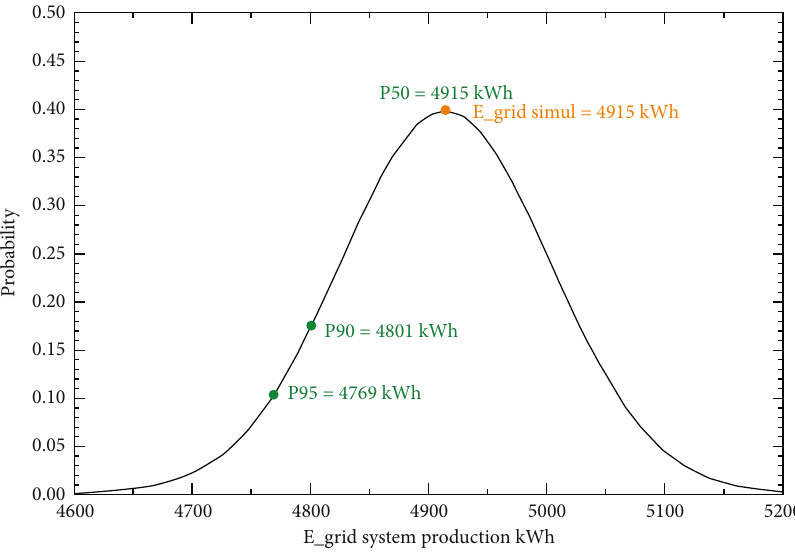
Figure 8: Annual energy production Table 7: Total cost of equipment for FPV.